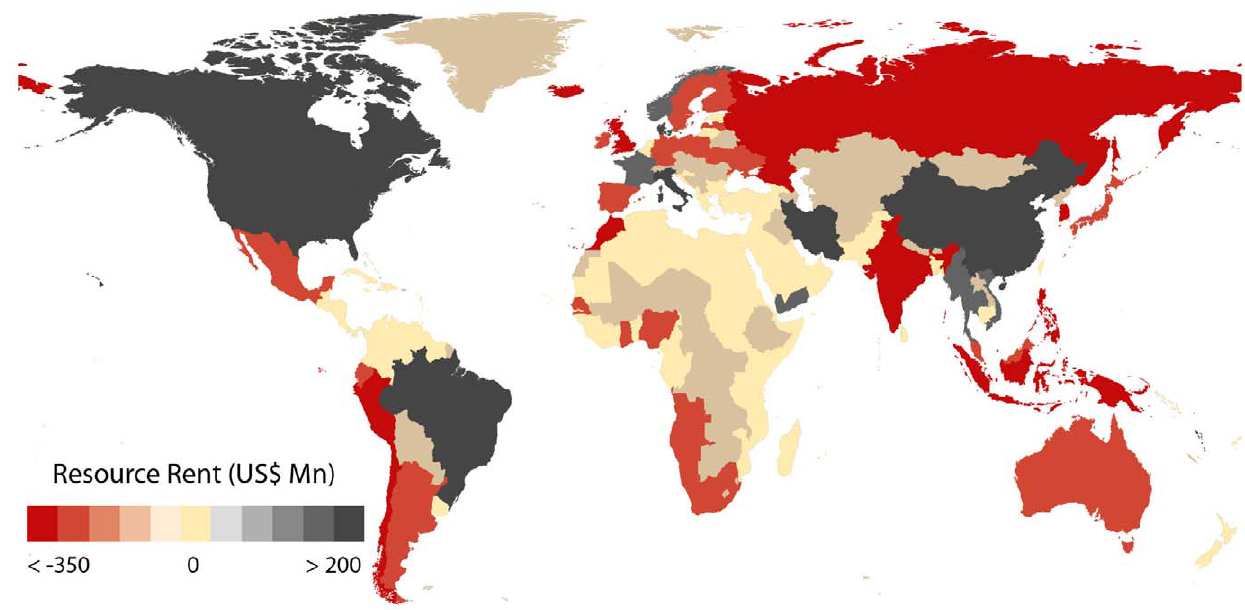
doi:10.1371/journal.pone.0040542.g001